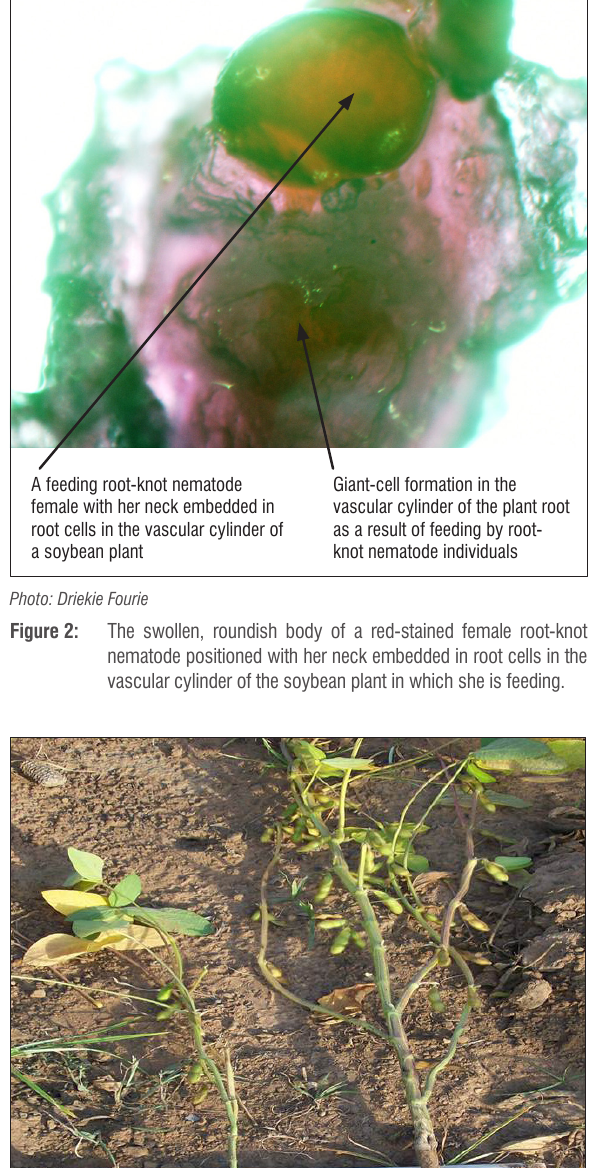
Figure 3: A root-knot nematode infected and galled soybean root system (left) and an uninfected one (right). The infected soybean plant (left) has yellow leaves and is stunted.